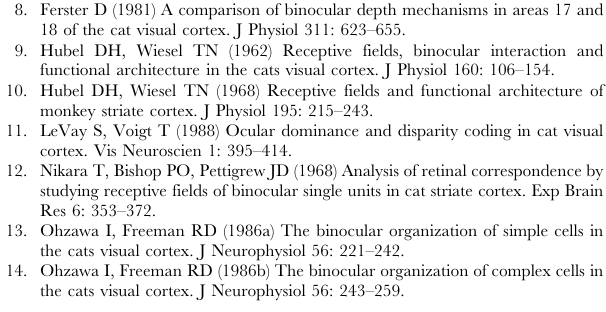
Table 4. OR anisotropy.